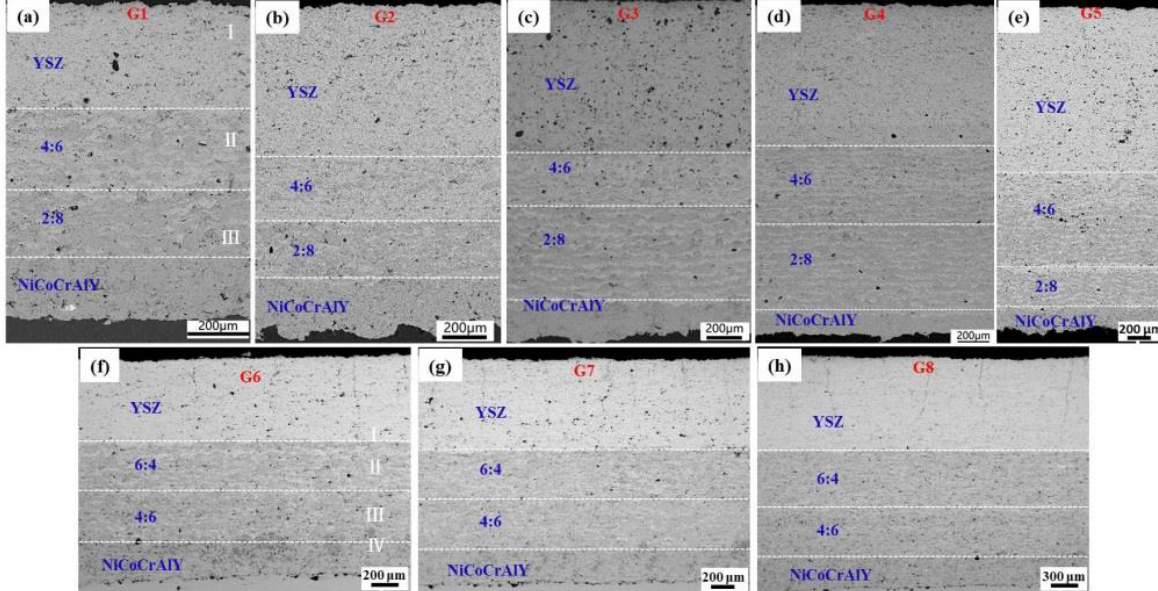
Figure 2. Cross-sectional SEM images of gradient NiCoCrAlY/YSZ coating with thickness of ( a ) G1, ( b ) G2, ( c ) G3, ( d ) G4, ( e ) G5, ( f ) G6, ( g ) G7 and ( h ) G8. The top layer is the 100 vol.% YSZ top coat. The thickness of TBCs ranges from 1000 to 3000 μm. In addition, a different ratio of NiCoCrAlY and YSZ for middle gradient layer